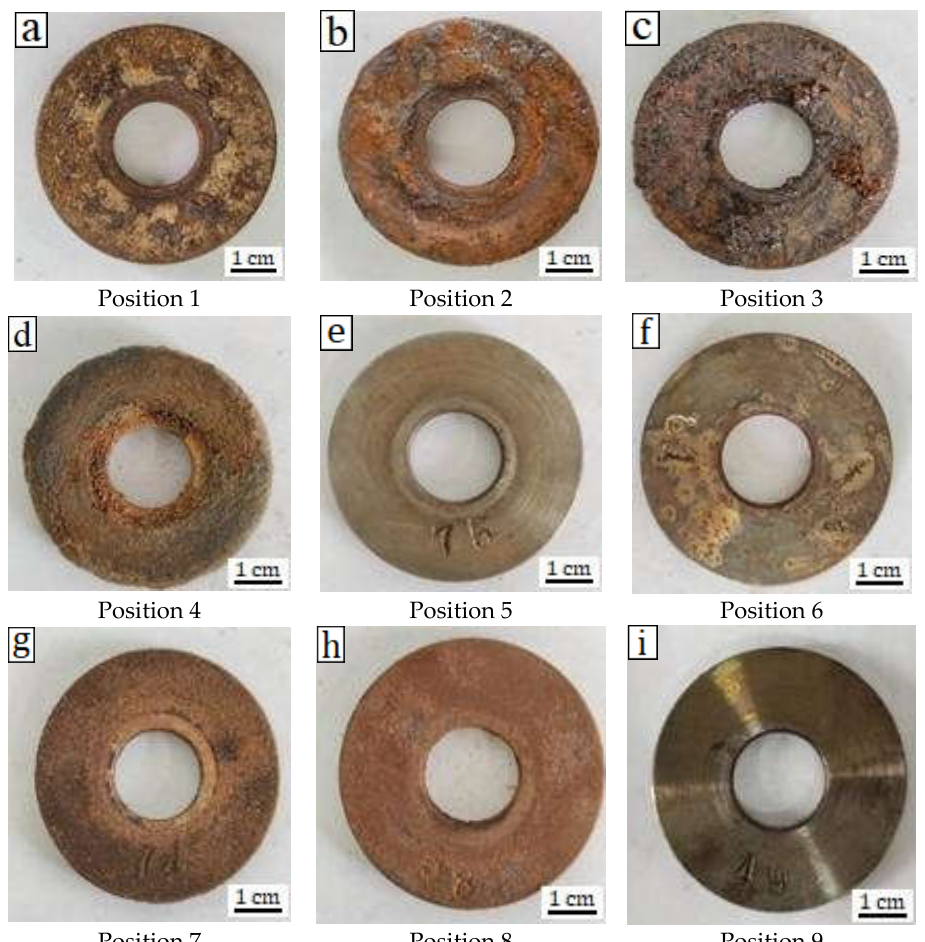
Figure 2. Macro-morphology of corrosion hanging ring at each site.